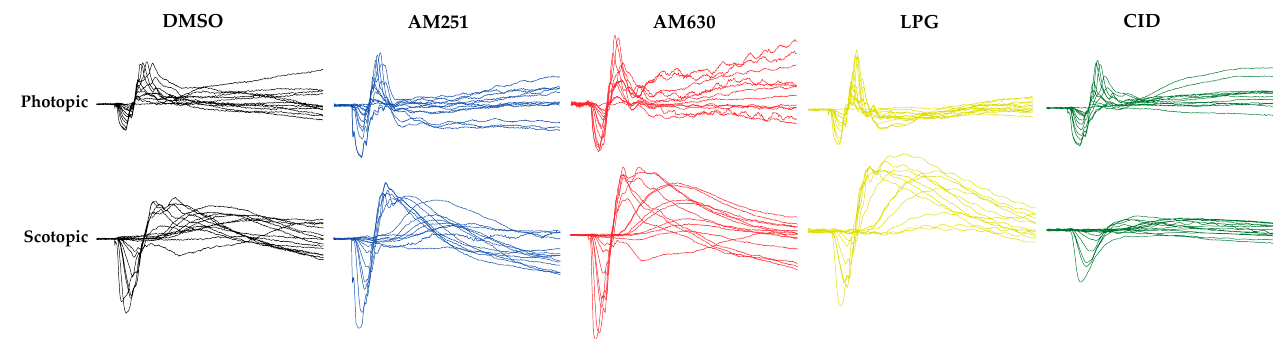
Figure 5. Raw photopic and scotopic ERGs in the different drug injection groups. The effect of modulating CB1R, CB2R, or GPR55 in the monkey retina. The intravitreal injection of AM251 (blue), an inverse agonist of CB1R, or AM630 (red), an inverse agonist of CB2R, causes an increase of the ERG photopic (under a 30 cd/m 2 white background-adapting field) and scotopic (recorded under dark-adapted conditions in a light-tight room) responses, compared to the vehicle, dimethyl sulfoxide (DMSO, in black) [20]. The intravitreal injection of lysophosphatidylglucoside (LPG), an agonist of GPR55 (yellow), causes an increase of the scotopic response, but not of the photopic response. Conversely, the intravitreal injection of CID16020046 (CID), an antagonist of GPR55, causes a decrease of the scotopic response, but not of the photopic response (green).